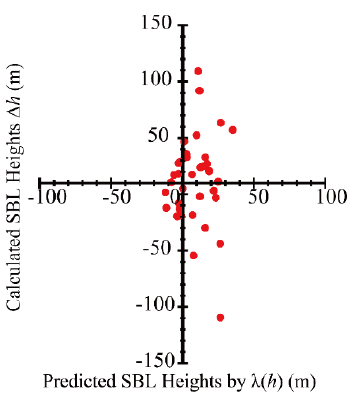
Figure 7. Scatter diagram of the predicted λ ( h ) versus the calculated height changes ∆ h in the stable